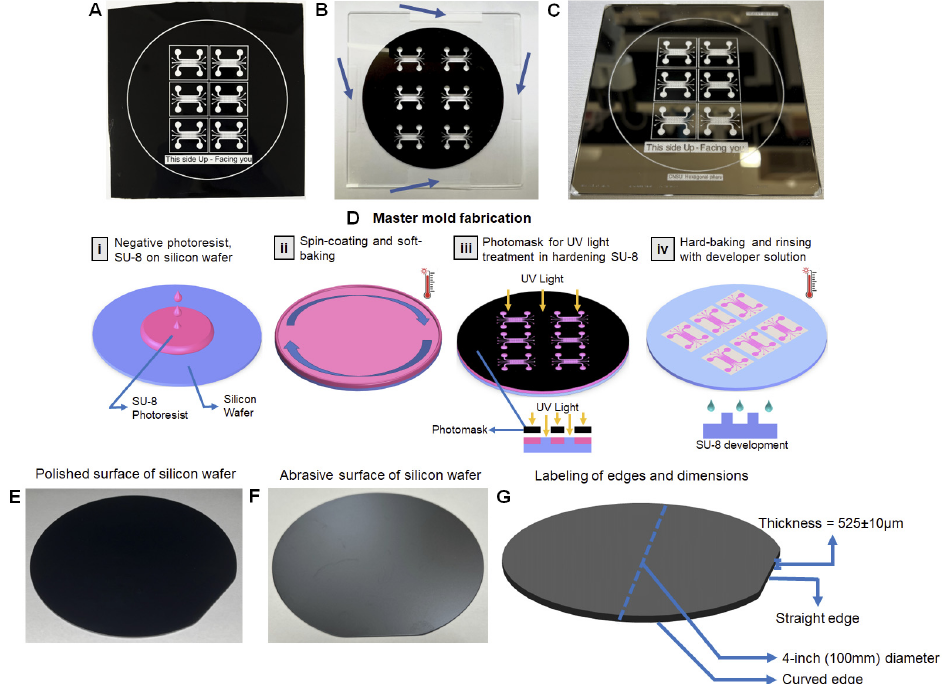
Figure 2. ( A ) Plastic-PAH photomask showing the design of the PAH-chip imprinted on a plastic sheet, which is low in price, supports a low resolution, and has weak stability but it is easy to